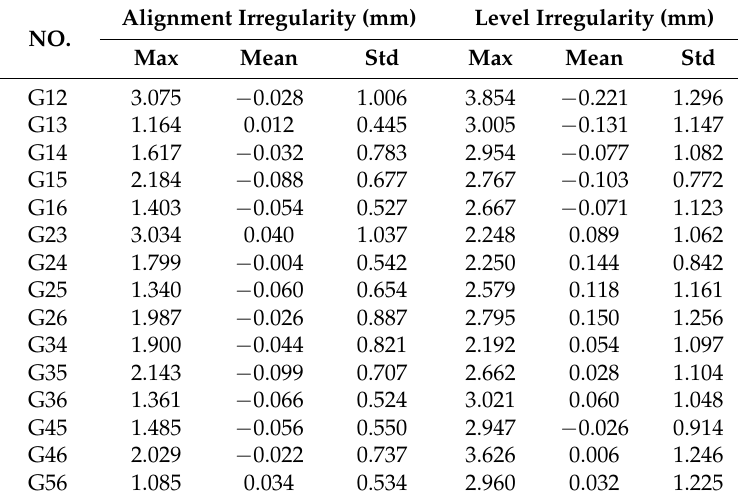
Table 1. Statistic of alignment irregularity and level irregularity